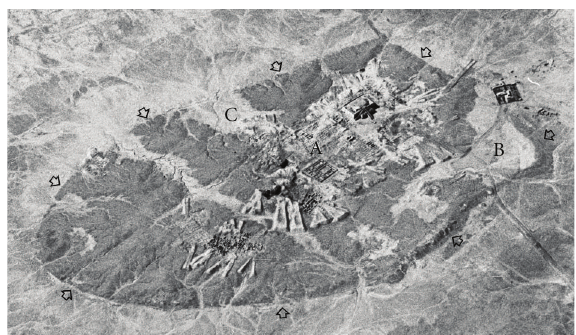
Figure 9: An oblique view of Tell al Muqayyar (Ur) in a Gambit KH-7 photograph acquired in February 1966: A: the sacred area on the top of the hill; B: the North Harbour; C: the West Harbour. The arrows indicate traces and remains of the city walls.